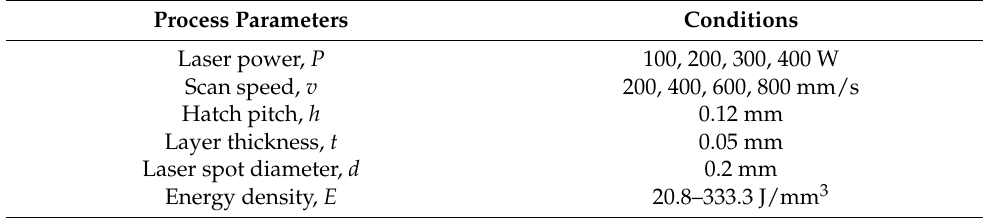
Figure 2. Cubic specimens fabricated at various conditions. Table 3. Fabrication conditions of cubic